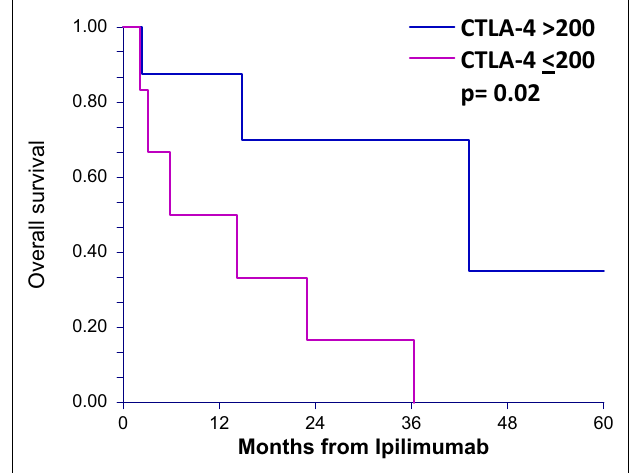
FIGURE 2 | Overall survival after ipilimumab treatment is greater in patients with serum CTLA4 levels above 200pg/mL for ipilimumab-treated patients . Overall survival curves (5years) of patients treated with ipilimumab comparing those with greater than 200pg/mL serum sCTLA4 to those with less than or equal to